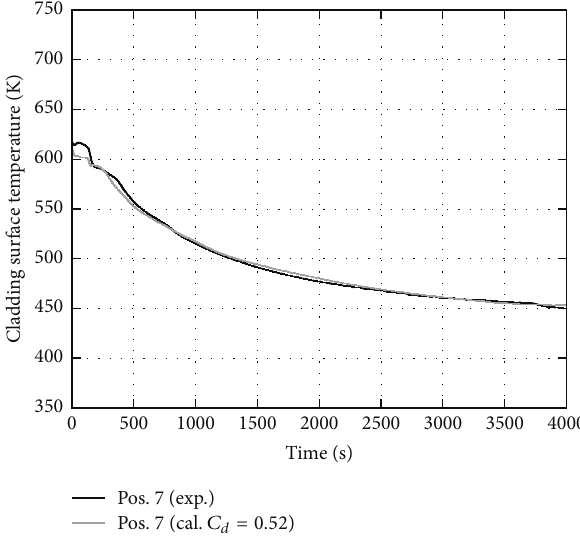
Figure 15: LSTF and RELAP5 results for cladding surface tempera- ture in case of release of dissolved gas.